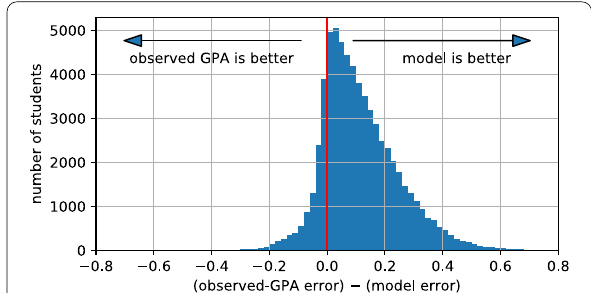
Fig. 1 The difference between the RMSE (root mean square error) of observed GPA and the logistic model (2) as a predictor of student grades. Values to the right of center indicate that the model (2) is a better predictor than observed GPA, while points to the left indicate the reverse. This shows that the model (2) is a better overall predictor of student grades than observed GPA